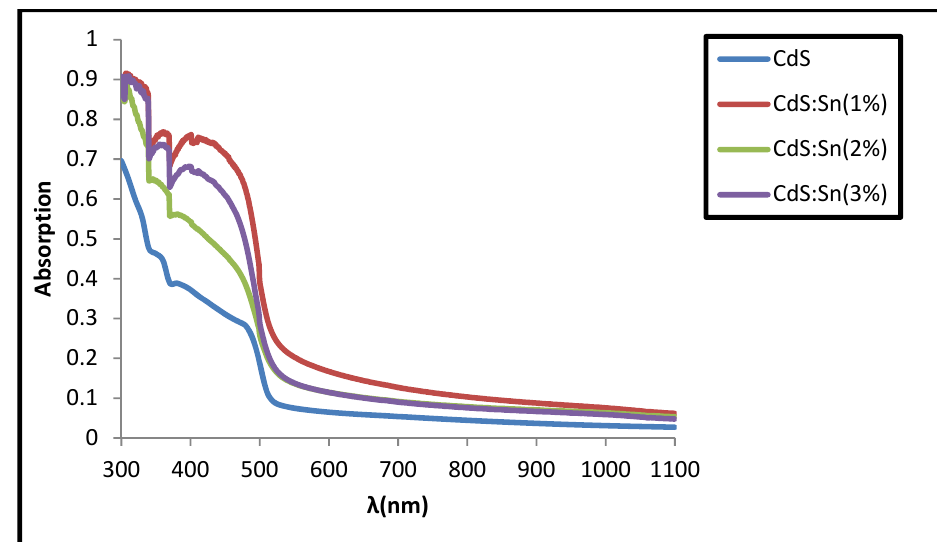
Fig. 3: Absorbance spectrums of CdS and CdS:Sn thin film